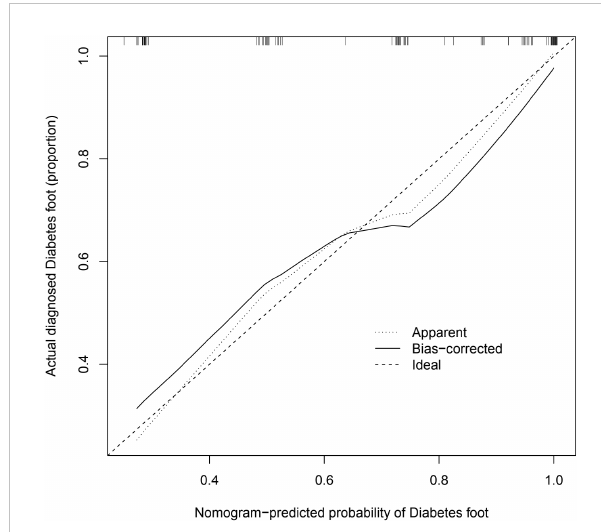
FIGURE 5 Calibration diagram. The calibration graph is a way to assess the accuracy of the prediction model for the column line graph. The signi fi cance of the calibration chart is that the closer the actual line in the chart is to the 45 degree diagonal the more accurate the prediction model is, and this image re fl ects the better accuracy of the prediction model we have